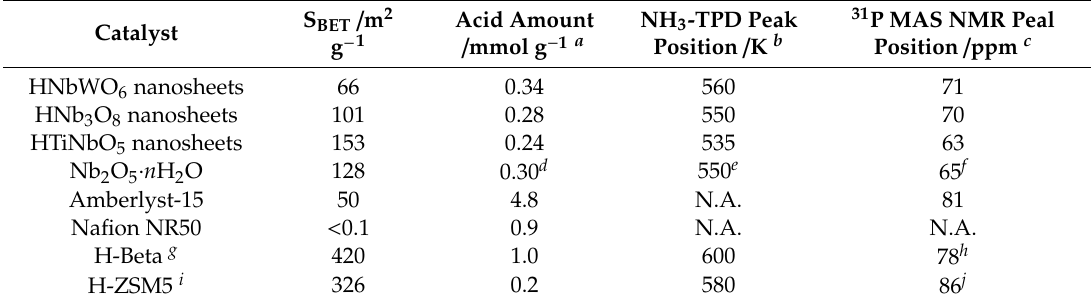
Table 1. Surface areas and acid properties of aggregated nanosheet catalysts